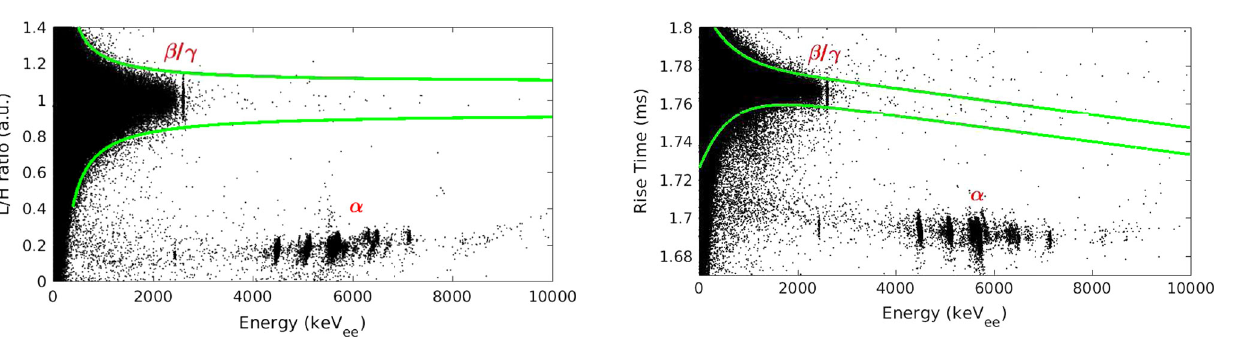
Fig. 5 Scatter plot of the light yield vs energy deposited in the phonon channel for one crystal. The β/γ band and the α clusters are clearly separated, as labelled in the figure